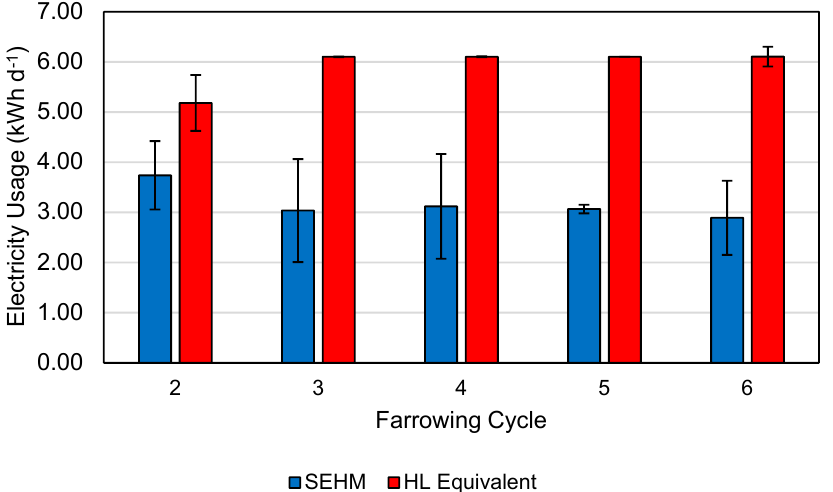
Figure 11. Electricity usage per day for SEHMs over five farrowing cycles utilized for the energy usage analysis. Error bars represent one standard deviation of the mean. Only the units with both litters farrowing on the same day were utilized for comparison. Note, farrowing cycle 2 had a higher maximum output setting than the later cycles, and the lower heat lamp equivalent is due to power outage issues on the farm late in the cycle.